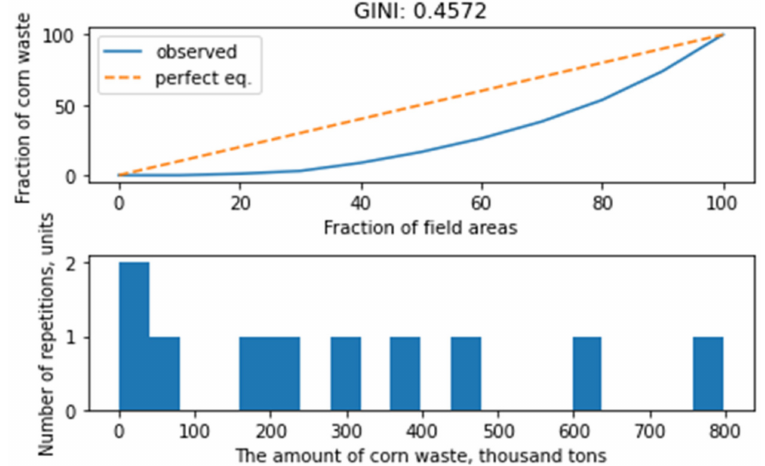
Figure 6. Lorentz curve, built on indicator II, for the conditions of Khmelnytskyi region (Ukraine).